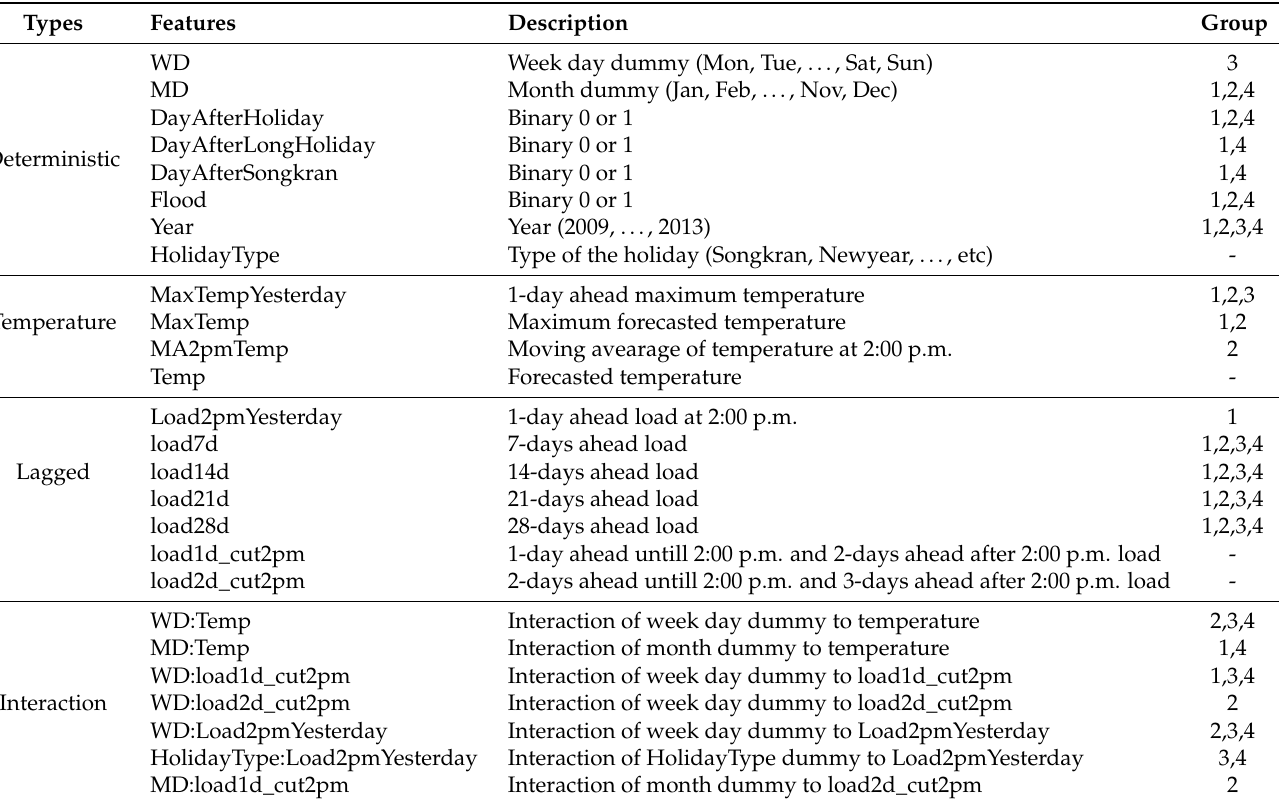
Table A1. List of selected input features in each